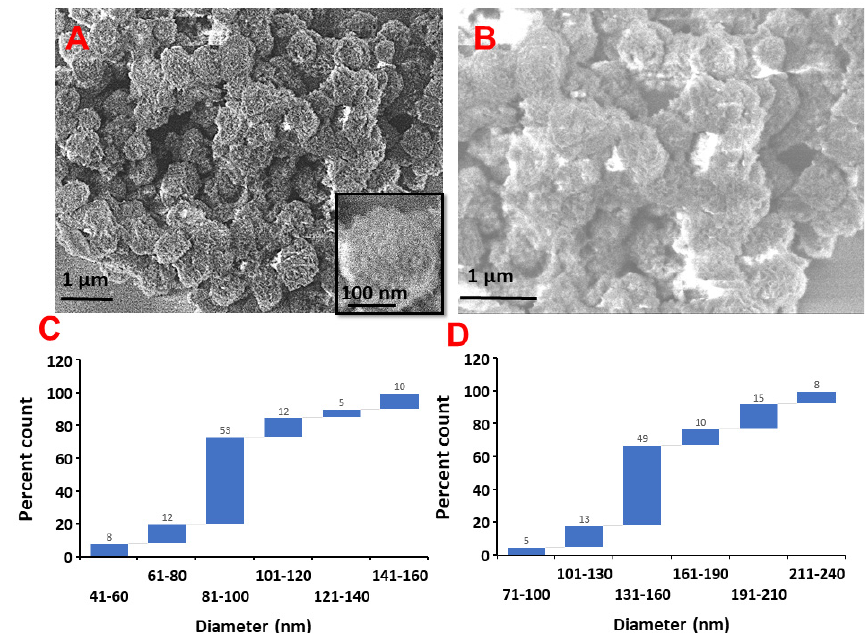
Figure 1. SEM images and size determination with per cent count (by using ImageJ software created by Wayne Rasband, retired from National institute of Health, with a permissive BSD-2 license, Madison, WI, USA) of ( A , C ) Ctr–mpHANCs ( B , D ) mpHANCs, respectively.